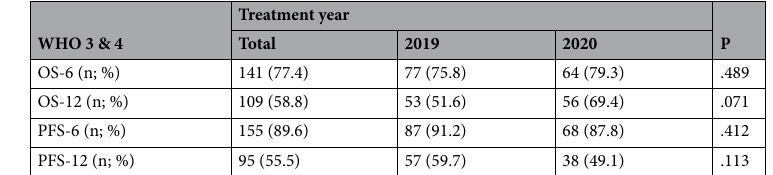
Table 4. Overall survival and progression-free survival at 6 and 12 months compared between the 2019 and 2020 cohorts of all patients (WHO grade 3 and 4) according to Kaplan–Meier estimation. OS—overall survival, PFS—progression-free survival,